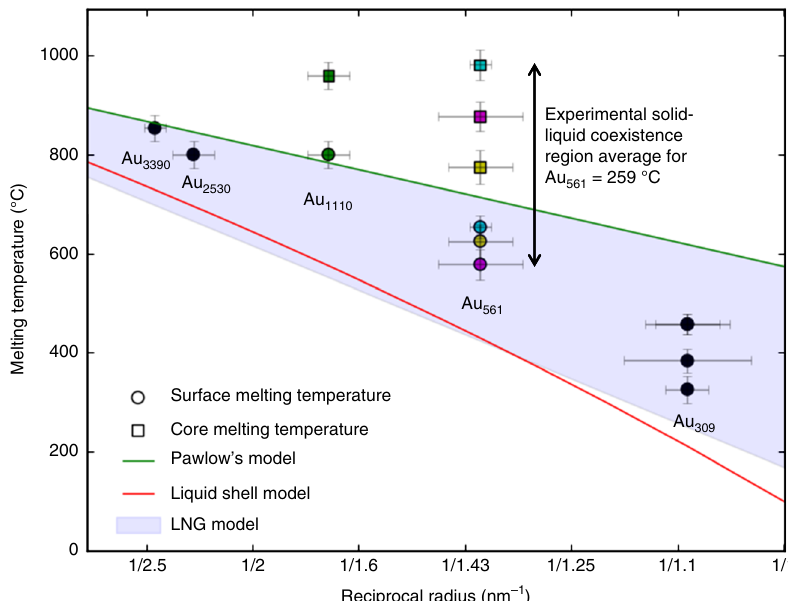
Fig. 2 Experimental, single particle measurements of melting point suppression in Au nanoparticles. Scatter points represent the experimental data: circles show surface melting temperatures and squares show core-melting temperatures. The cluster sizes (number of atoms) are indicated on the plot and the corresponding core and surface melting temperatures have the same colour. The solid green line is Pawlow ’ s model from ref. 49 , the solid red line is the liquid shell model from ref. 8 and the blue region is the liquid nucleation and growth model melting sector from refs. 22,50 . The error bars on the melting temperatures are systematic errors arising from the temperature window, the temperature stability of the MEMS heating chip and the 5% heating chip calibration